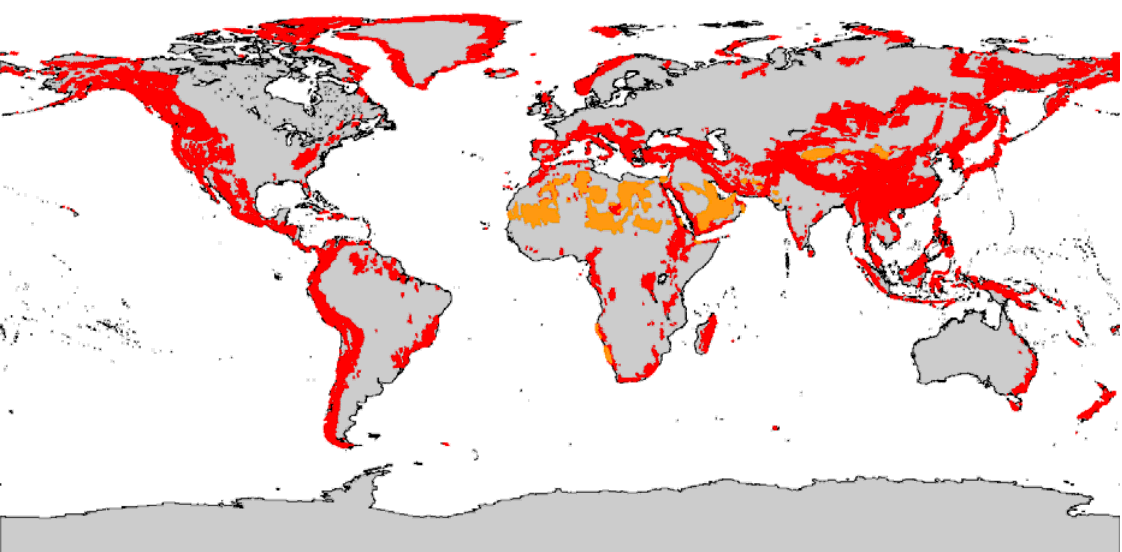
Figure 1. Regions affected by shadow and layover effects (in red) have been identified from terrain slope calculations. Deserts regions (in orange) have been derived from TanDEM-X coherence data of the first and second year